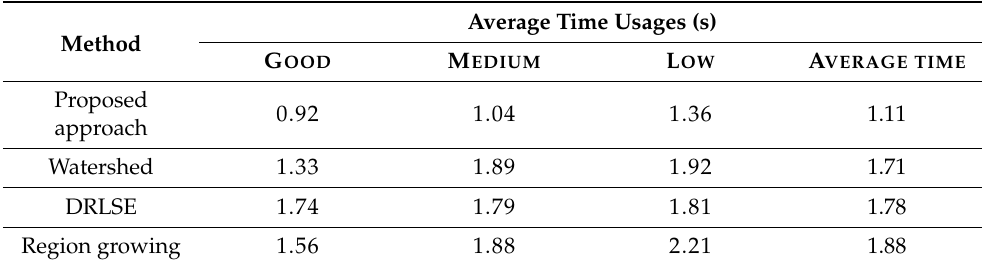
Table 4. Performance